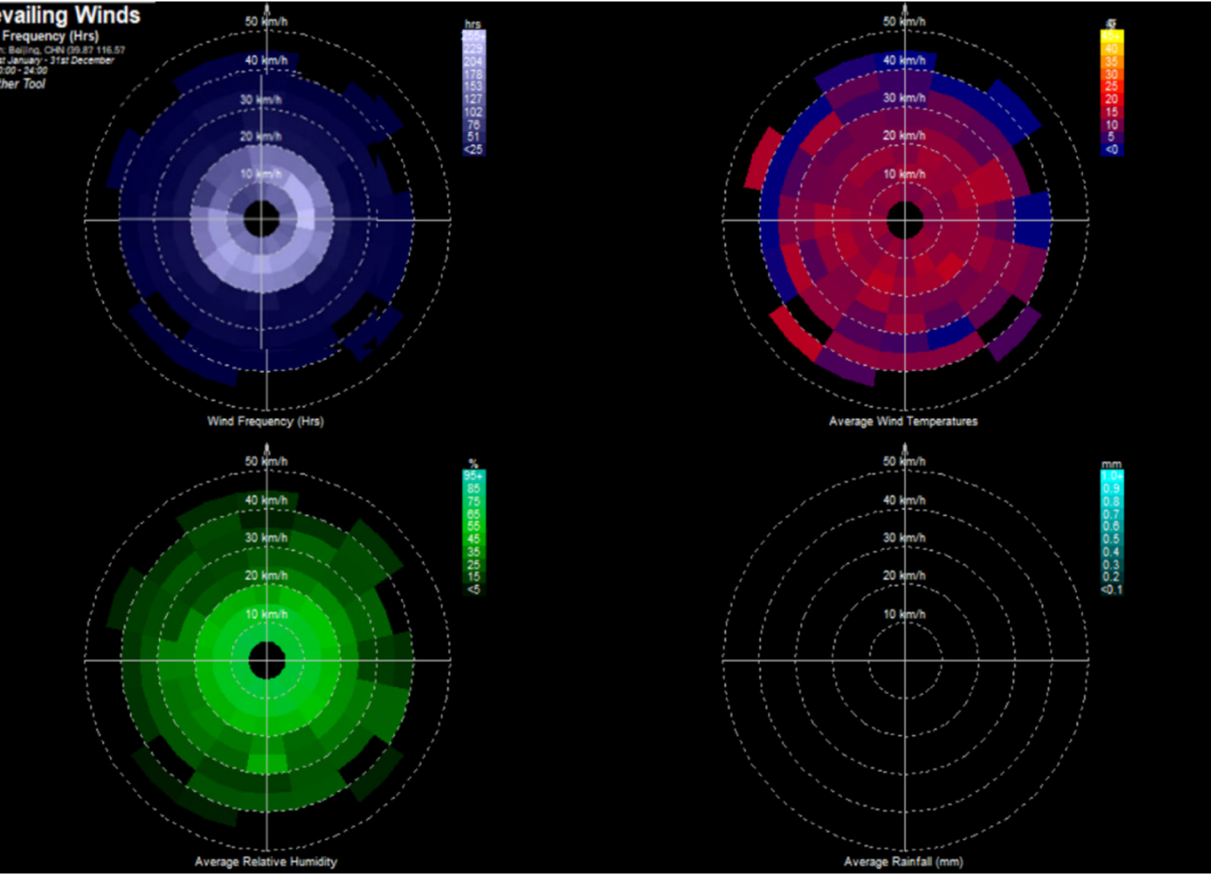
Figure 21. Wind frequency, direction, and speed